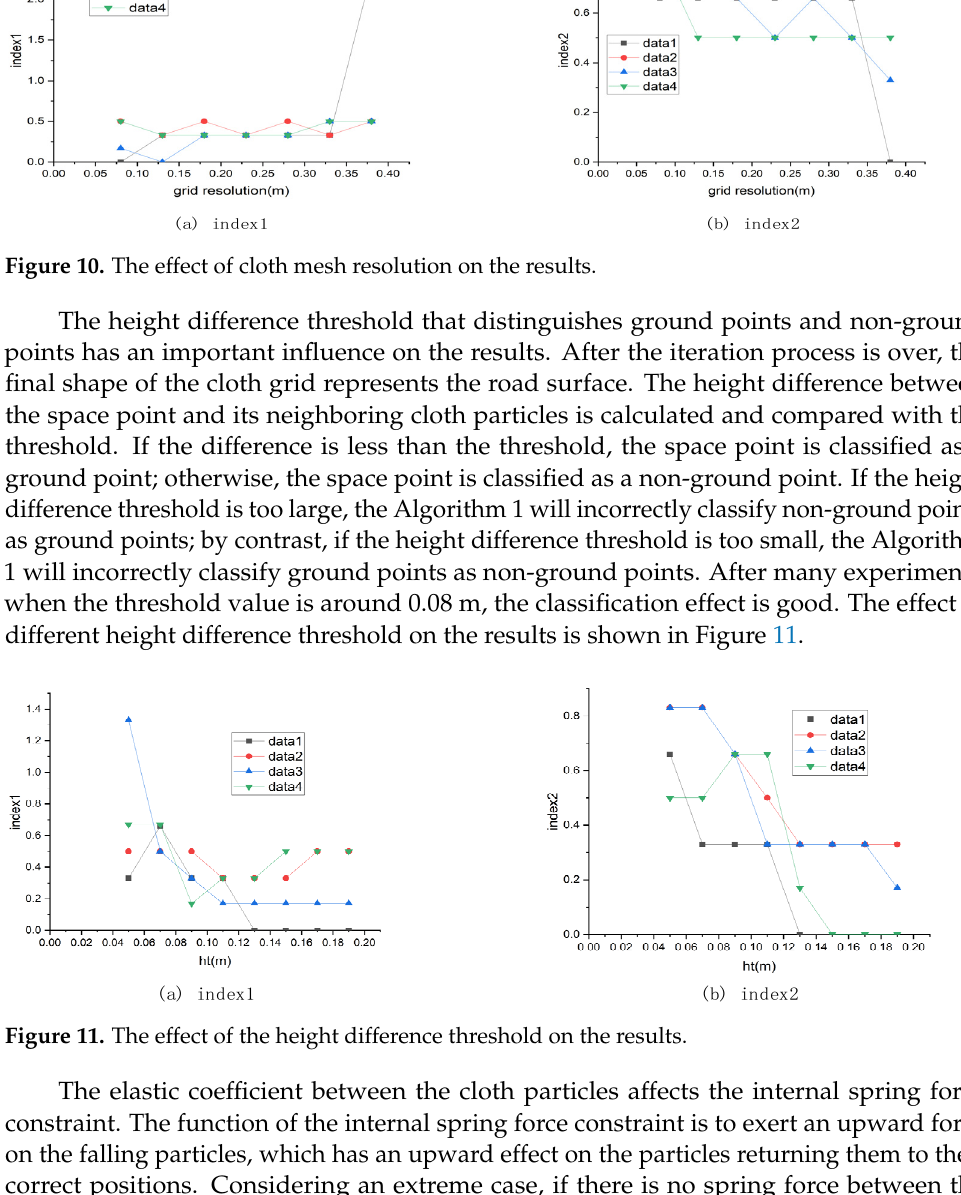
Figure 11. The effect of the height difference threshold on the results. The elastic coefficient between the cloth particles affects the internal spring force con- straint. The function of the internal spring force constraint is to exert an upward force on the falling particles, which has an upward effect on the particles returning them to their correct positions. Considering an extreme case, if there is no spring force between the par- ticles, the falling of the particles in the holes is only restricted by collision detection. The particles fall to a very deep position in the holes, which makes it impossible to accurately simulate the road surface. For different cloth grid resolution and height difference thresh- old, the best elastic coefficient can be determined through experiments. The effect of dif- ferent elastic coefficients on the results is shown in Figure 12.